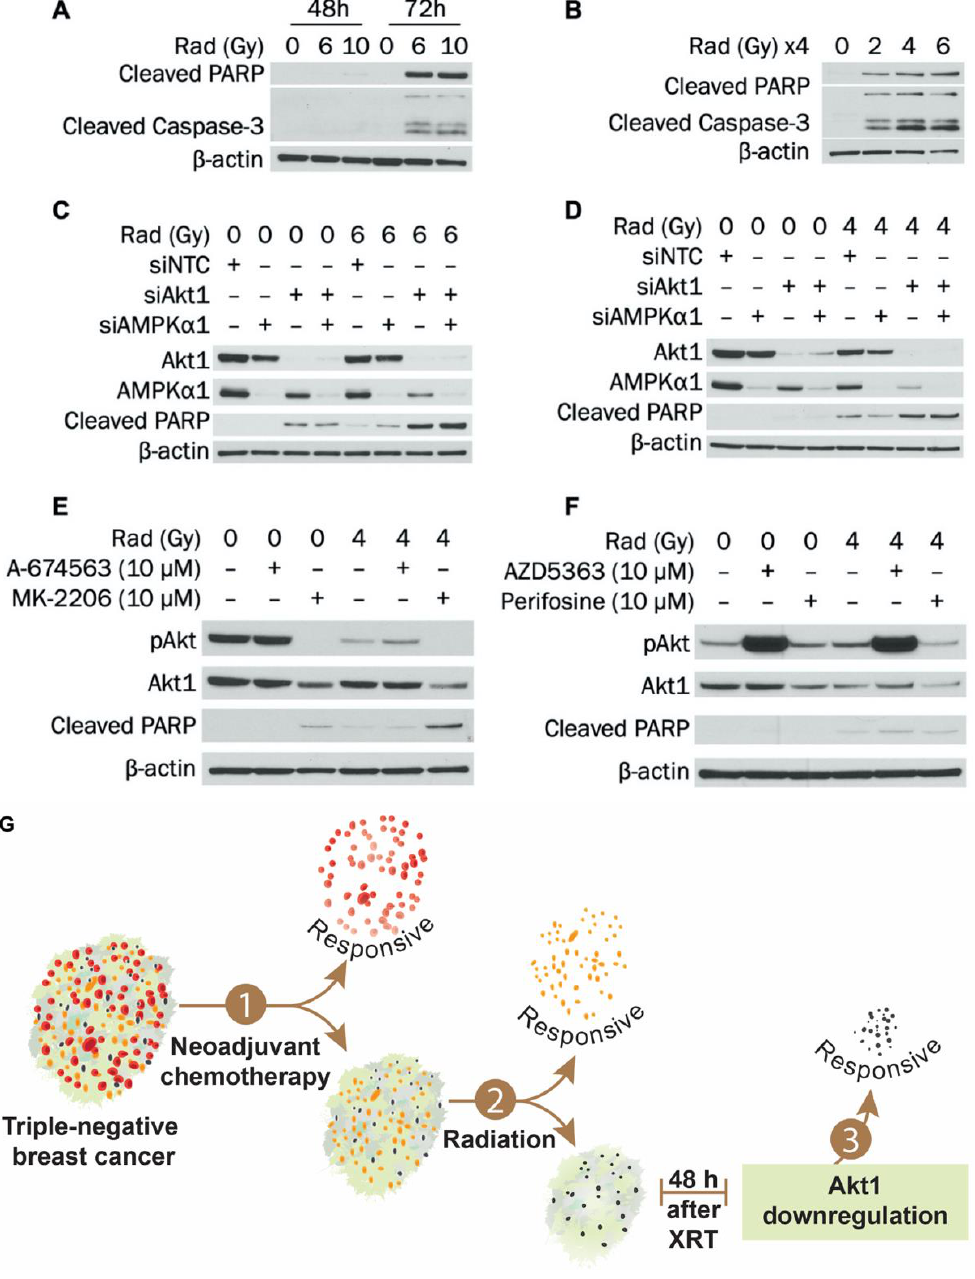
Figure 5. Knockdown of Akt1 potentiates radiation-induced apoptosis in MDA-MB-231 cells. ( A ) MDA-MB-231 cells were exposed to 0, 6, or 10 Gy radiation dose and collected 48 h or 72 h after irradiation. Expression of cleaved PARP and cleaved caspase-3 was determined by Western blot. ( B ) MDA-MB-231 cells were exposed to 0, 2, 4, or 6 Gy radiation dose daily for 4 d and collected 24 h after the last radiation treatment. Expression of cleaved PARP and cleaved caspase-3 was determined by Western blot. ( C ) MDA-MB- 231 cells were transfected with siRNA to AMPKα1, Akt1, or AMPKα1/Akt1. Transfection concentrations were (1) individual siRNA: 50 nM, (2) combination siRNA: 50 nM each (100 nM total), and (3) NTC: 100 nM. Cells were exposed to 0 or 6 Gy radiation dose 24 h after transfection and collected 48 h after radiation. Expression of AMPKα1, Akt1, and cleaved PARP was determined by Western blot. ( D ) MDA-MB-231 cells were exposed to 0 or 4 Gy radiation dose and then transfected with siRNA to AMPKα1, Akt1, or AMPKα1/Akt1 on the same day. Transfection concentrations were (1) individual siRNA: 50 nM, (2) combination siRNA: 50 nM